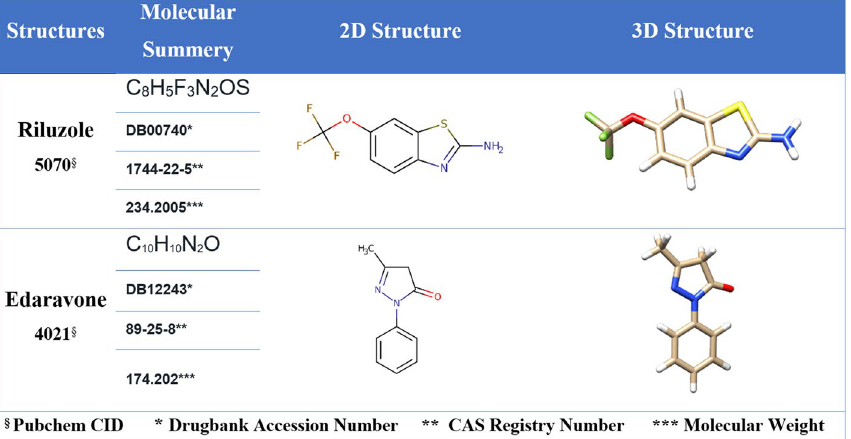
Figure 2. Two-dimensional and three-dimensional view of ALS FDA-approved drugs (riluzole and edaravone) before and after B3LYP protocol optimization of spatial energy of the Gaussian program. The structure of the ( A ) Riluzole and ( B ) Edaravone were obtained from the Drug bank (www. drugb ank.